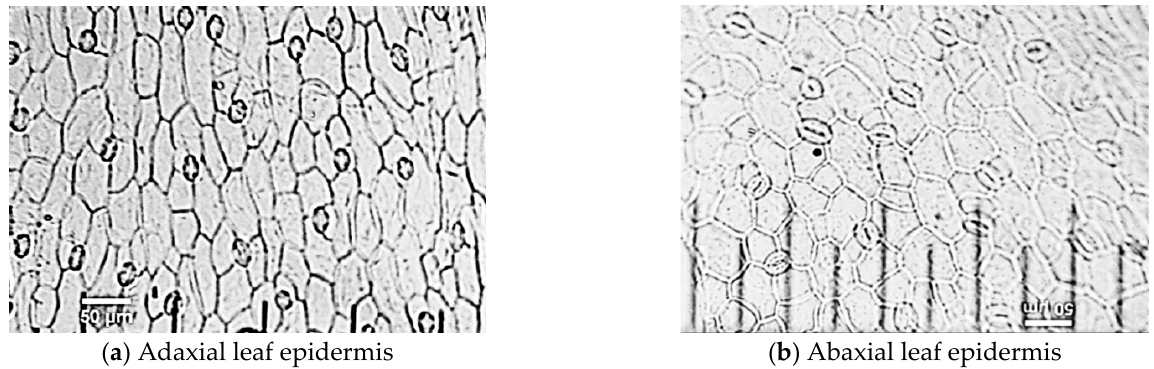
Figure 2. Adaxial epidermis ( a ) and abaxial epidermis ( b ) of hydroponically cultivated spinach leaves under R5B2G3 treatment. Scale bar is 50 µm.